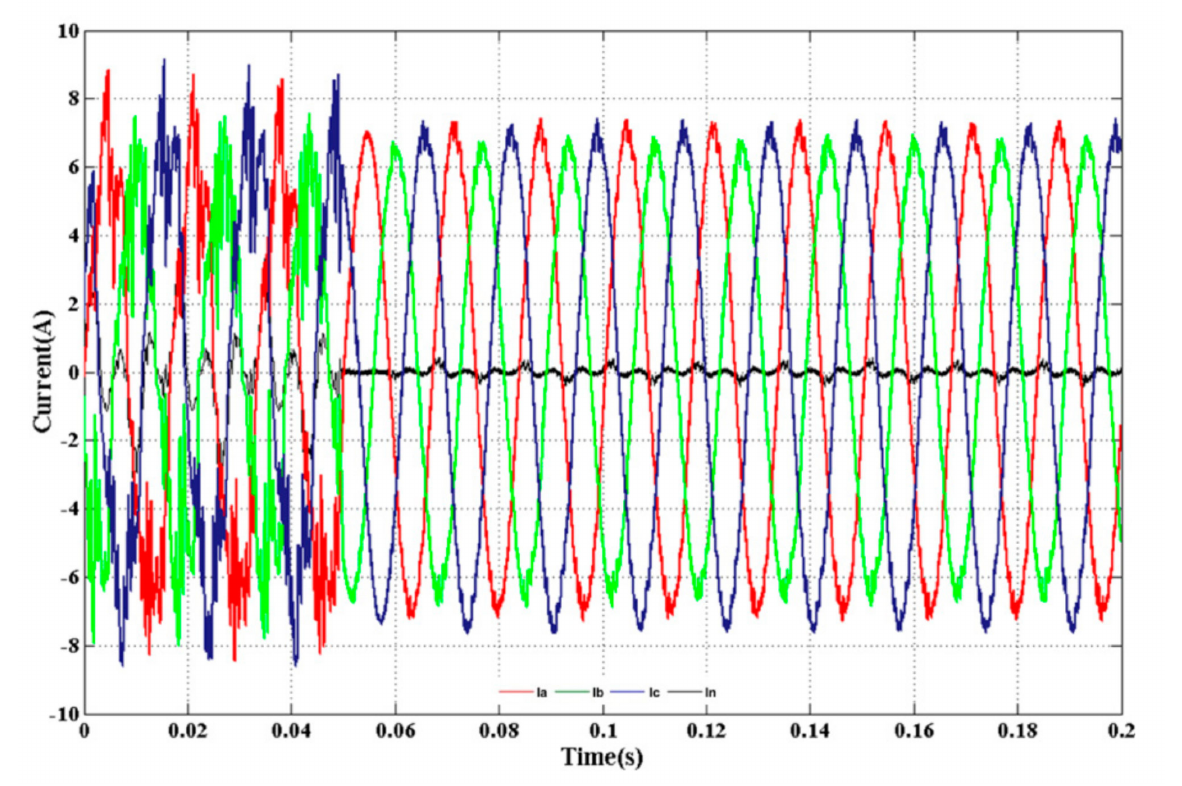
Figure 19. Experimental result of the RNN for case 3.